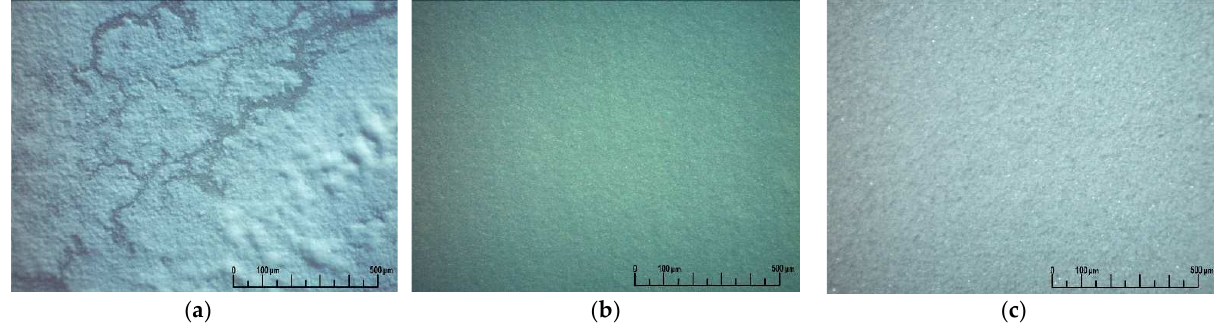
Figure 3. Dependences in the specific weight of the deposited films on the applied EPD voltage for the SDC-gn/lec, SDC-gn and BCS-CuO suspensions (at a constant deposition time of 1 min). The morphology of the green EPD coatings deposited on the Ni-foil substrate (80 V, 1 min) is shown in Figure 4.